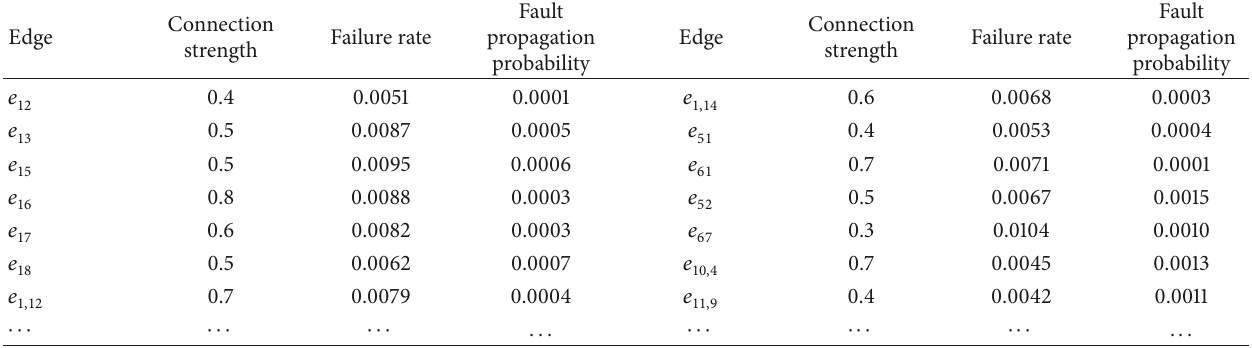
Table 4: Functional properties of several edges.